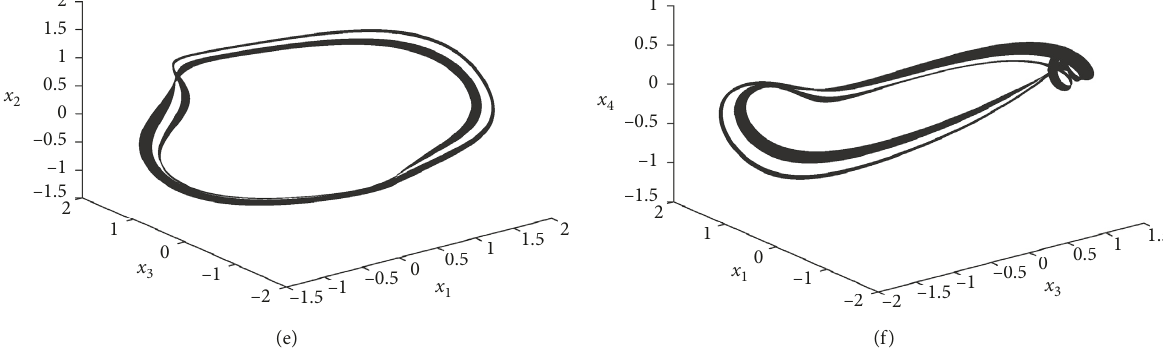
Figure 16: Quasiperiodic motion occurs when b